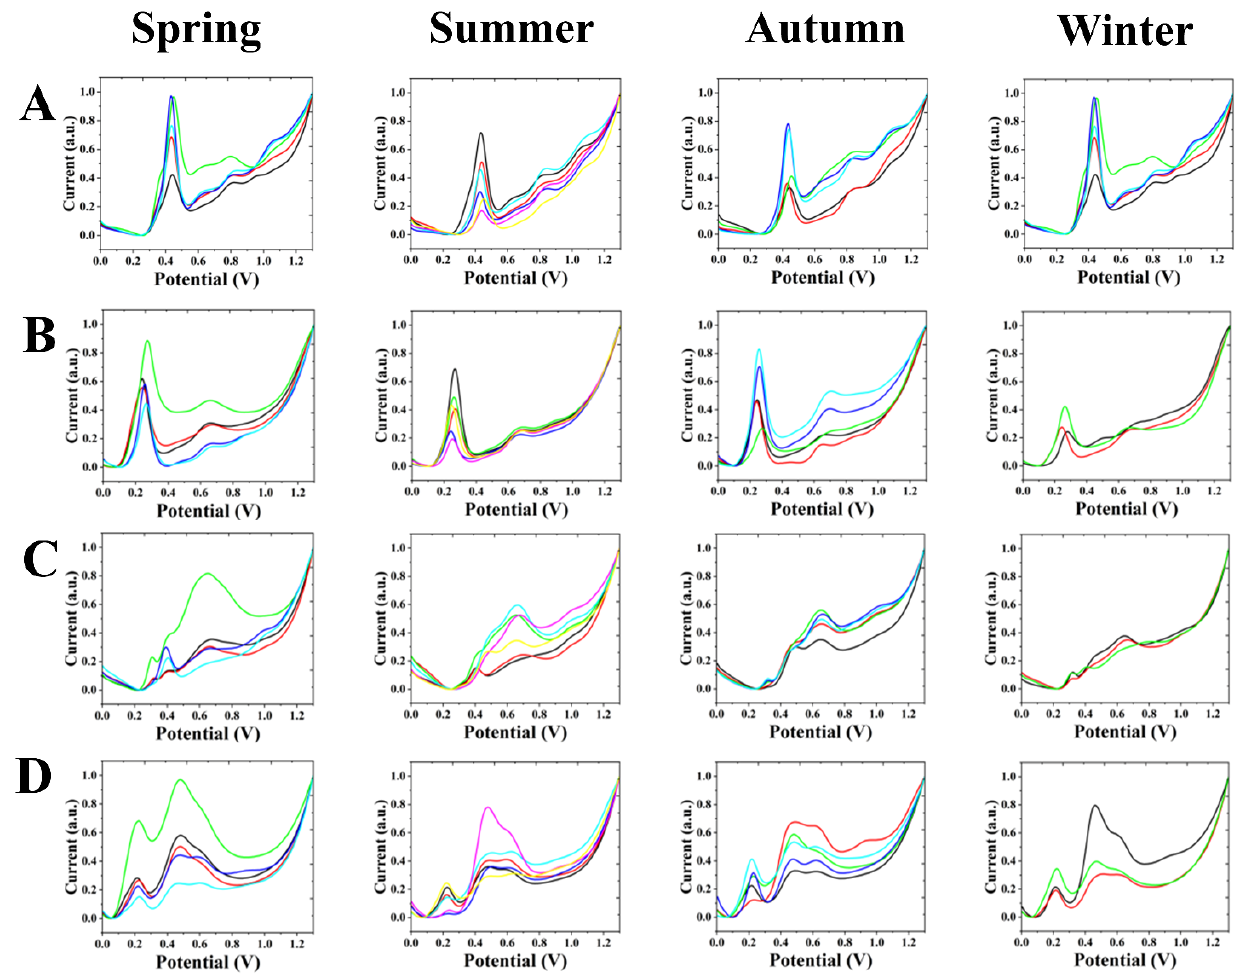
Figure 2. Electrochemical fingerprints of A. cinnamomifolium during different seasons under ( A ) wa- ter-ABS, ( B ) water-PBS, ( C ) ethanol-ABS and ( D ) ethanol-PBS